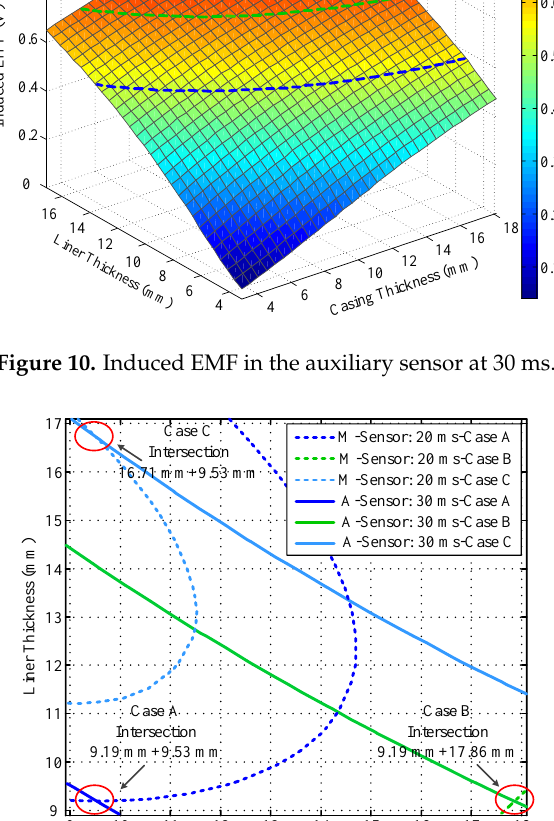
Figure 10. Induced EMF in the auxiliary sensor at 30 ms.